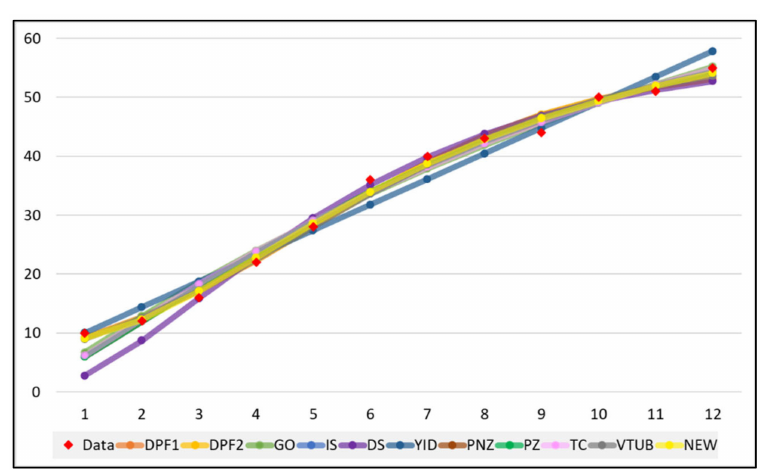
Figure 6. Mean value functions of the models for dataset